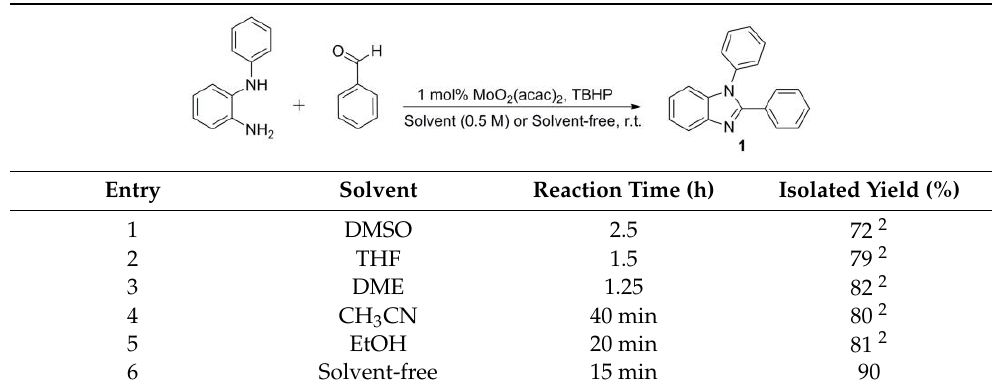
Table 1. Solvent effects on MoO 2 (acac) 2 -catalyzed synthesis of 1 1 .